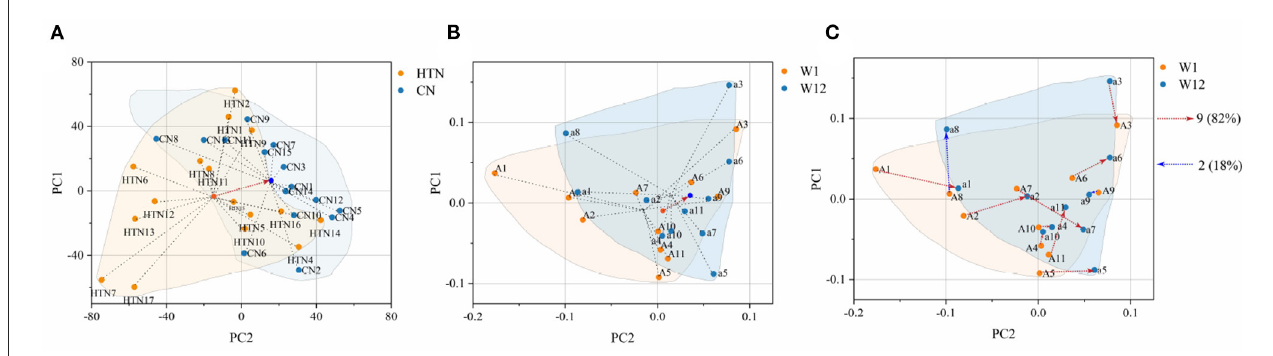
FIGURE6 Change trend of gut microbiota structure. (A) PCoA analysis between hypertensive and healthy populations; (B) PCoA analysis before and after LZJ intervention; (C) Change trajectory of BP responders affected by LZJ. The black dotted line is the connection between samples in the group. The red arrow is the displacement trajectory in the same direction as that of the healthy population, and the blue arrow is the displacement trajectory in the opposite direction.